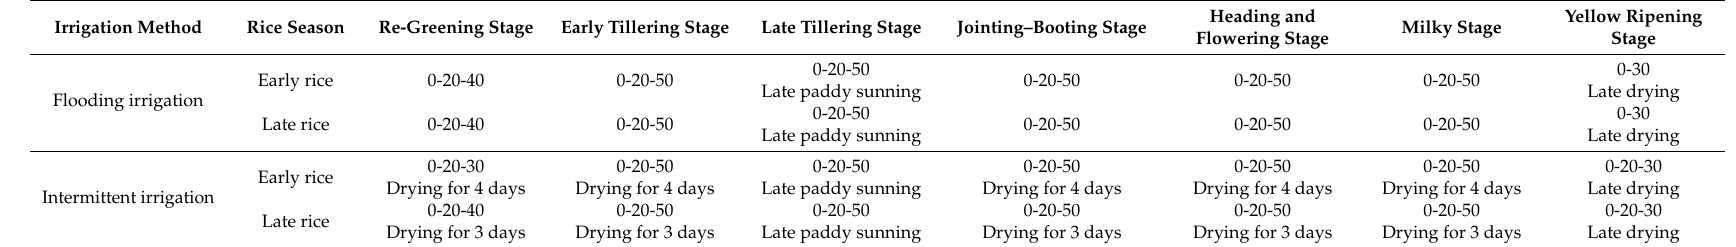
Table 1. Water layer control standards in different irrigation methods for early and late rice (Unit: